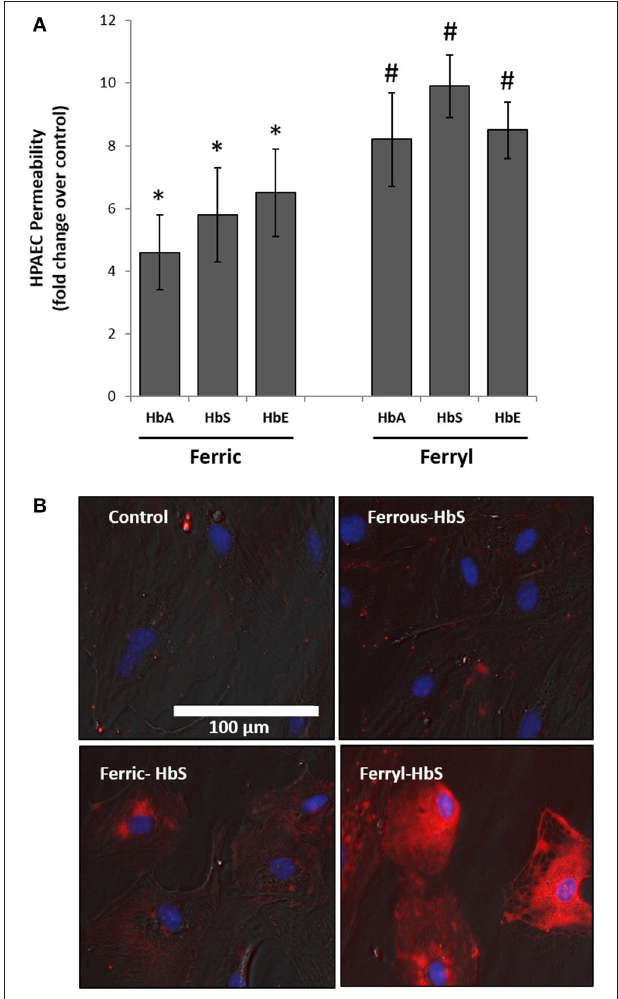
FIGURE 4 | Oxidized hemoglobin variants cause rapid disruption of pulmonary endothelial monolayer and generate oxidative stress. (A) HPAEC monolayer were grown on Transwell inserts and then exposed to either ferric or ferryl forms of HbA, HbS, or HbE at equimolar concentration (100 µ M) for 6h in the presence of FITC conjugated dextran, 40 KD. Endothelial monolayer integrity was assessed by measuring the passage of FITC-dextran as mentioned in the methods section. Values are presented as average fold difference over control ( N = 3). Differences between groups were compared using Mann-Whitney U -test. * P < 0.05 and # P < 0.001 vs. respective controls. (B) HPAEC were exposed to ferryl Hb proteins at equimolar concentration (100 µ M) for 6h. Following incubation cells were washed thoroughly and probed with spin trapping agent DMPO. DMPO-nitrone adducts formed with oxidatively modified proteins within HPAEC were visualized by immunofluorescence method using anti-DMPO-nitrone antibody. Images shown are from one representative set of experiments repeated three